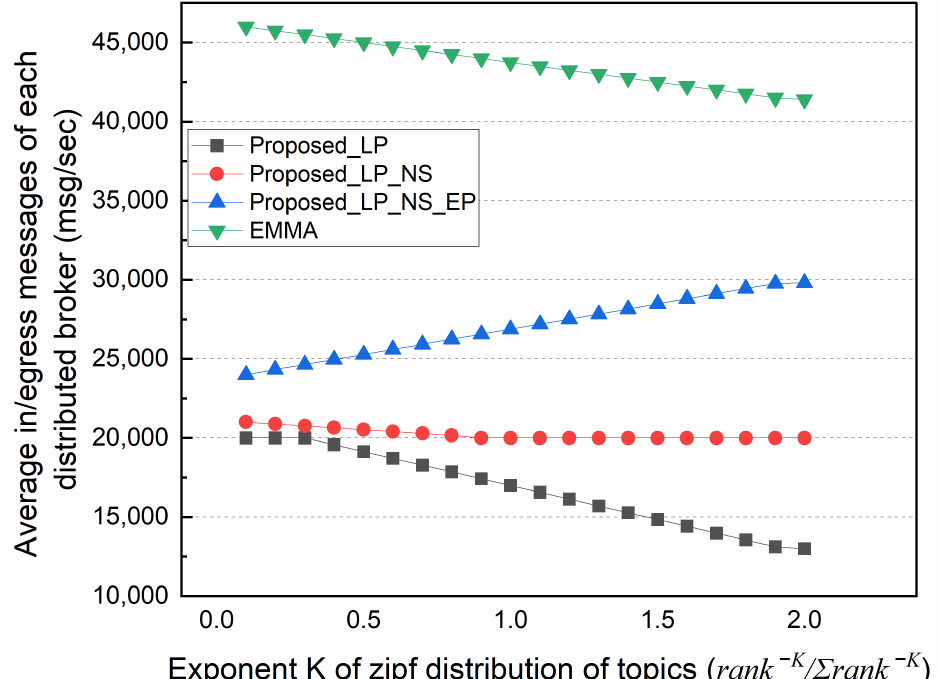
Figure 15. Average number of in/egress messages according to topic